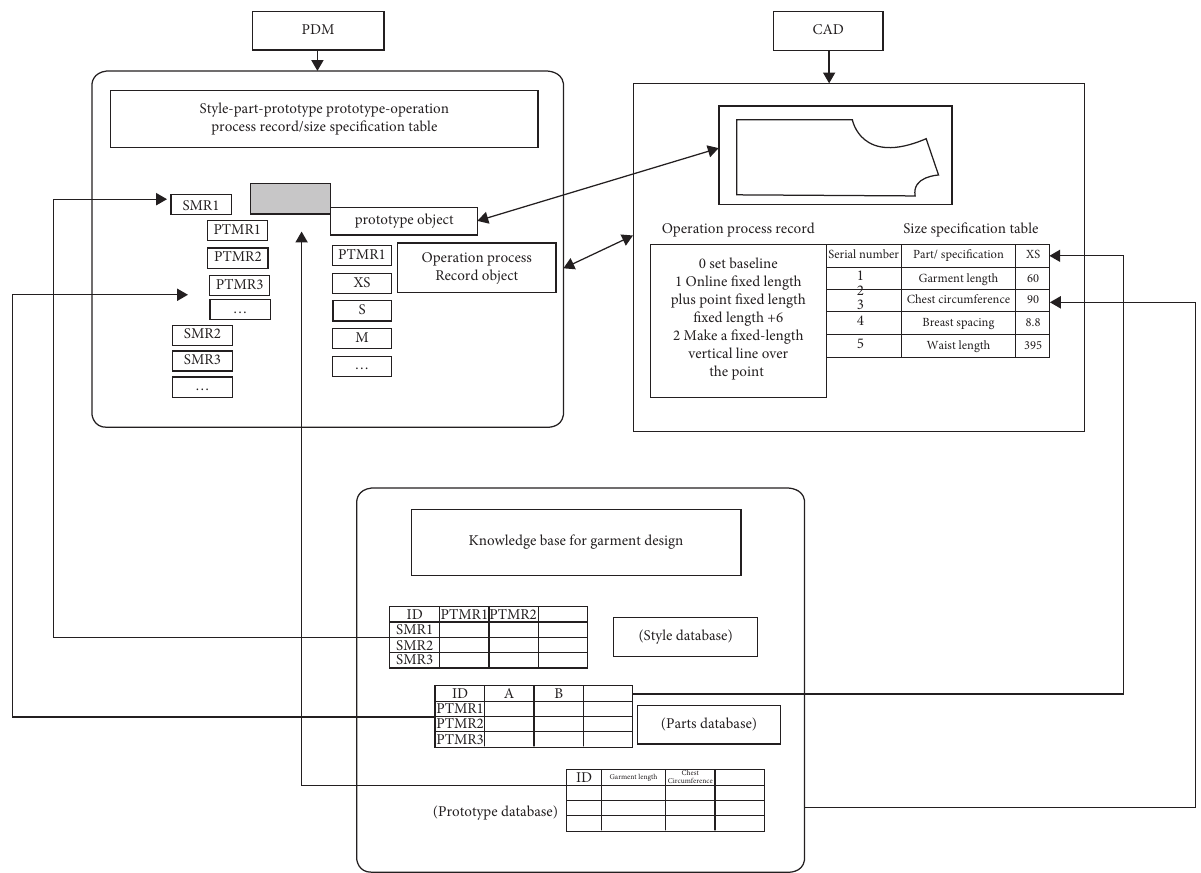
Figure 11: Logical data structure of system